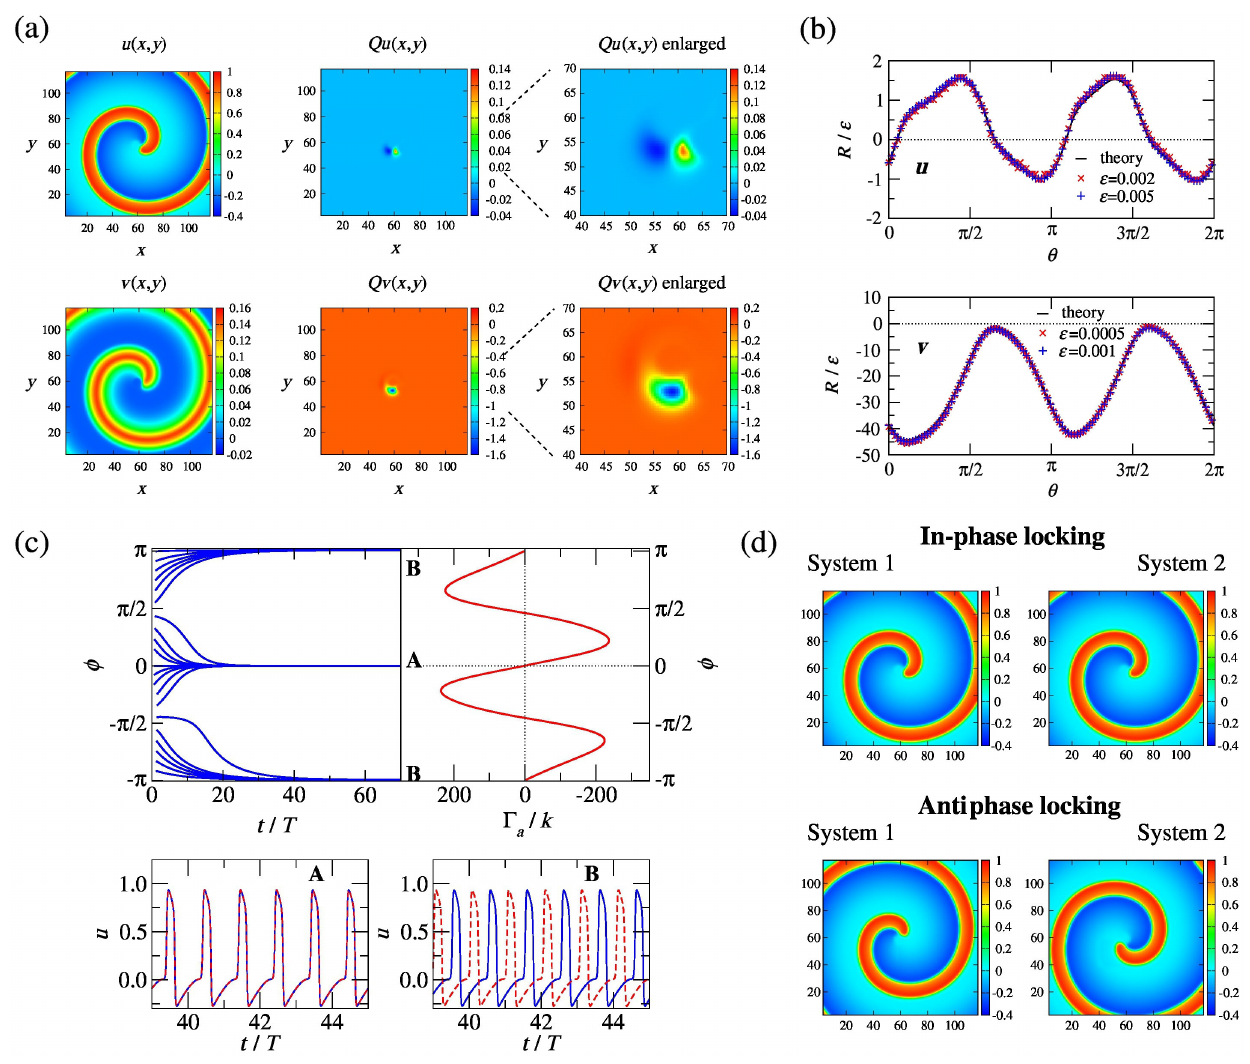
FIG. 4. Rotating spirals. The system is a 2D square of side L ¼ 120 with no-flux boundary conditions. To pin the spiral at the center, a localized circular heterogeneity of radius r 0 ¼ 4 is introduced to the parameter α ð x; y Þ as α ð x; y Þ ¼ α 0 þ ð α 1 − α 0 Þ exp ð − r 4 =r 4 0 Þ , where r ¼ ½ð x − L= 2 Þ 2 þ ð y − L= 2 Þ 2 (cid:1) 1 = 2 is a distance from the center of the system. We assume α the highest at the center. Other parameters are fixed at τ − 1 ¼ 0 . 005 , γ ¼ 2 . 5 , κ ¼ 0 . 15 , and δ ¼ 0 . With these parameters, the